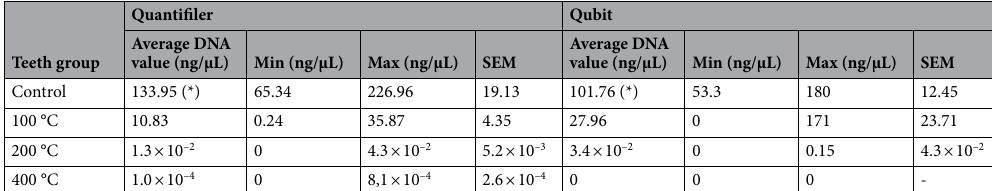
Table 1. DNA concentration of control and incinerated group of teeth using Quantifiler and Qubit methods. *Significant differences (p < 0.01) between control group and all incinerated groups with Quantifiler and between control group and incinerated group at 100 and 200 °C with